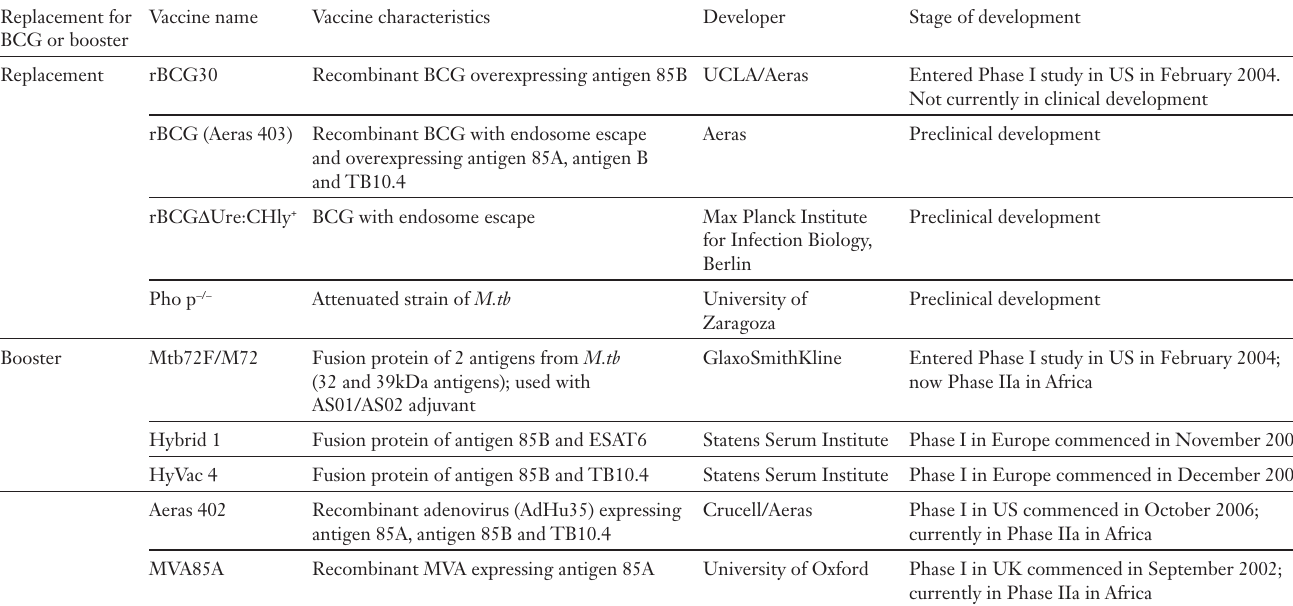
leading prophylacticTB vaccine candidates in Replacement for Vaccine name